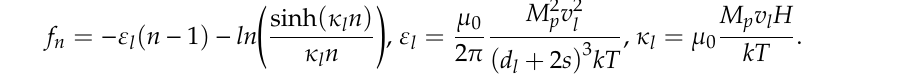
. γ in terms of the field H , shear rate